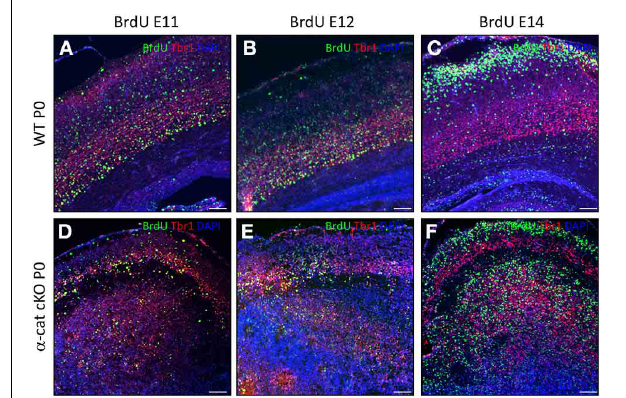
FIGURE 4 | Birth-dating analysis in the α -cat cKO cortex. Fluorescence micrographs of coronal cortical sections of P0 WT (A–C) and α -cat cKO (D–F) immunostained as indicated. BrdU was injected at E11 (A,D) , E12 (B,E) , or E14 (C,F) . Scale bars: 100 μ m.